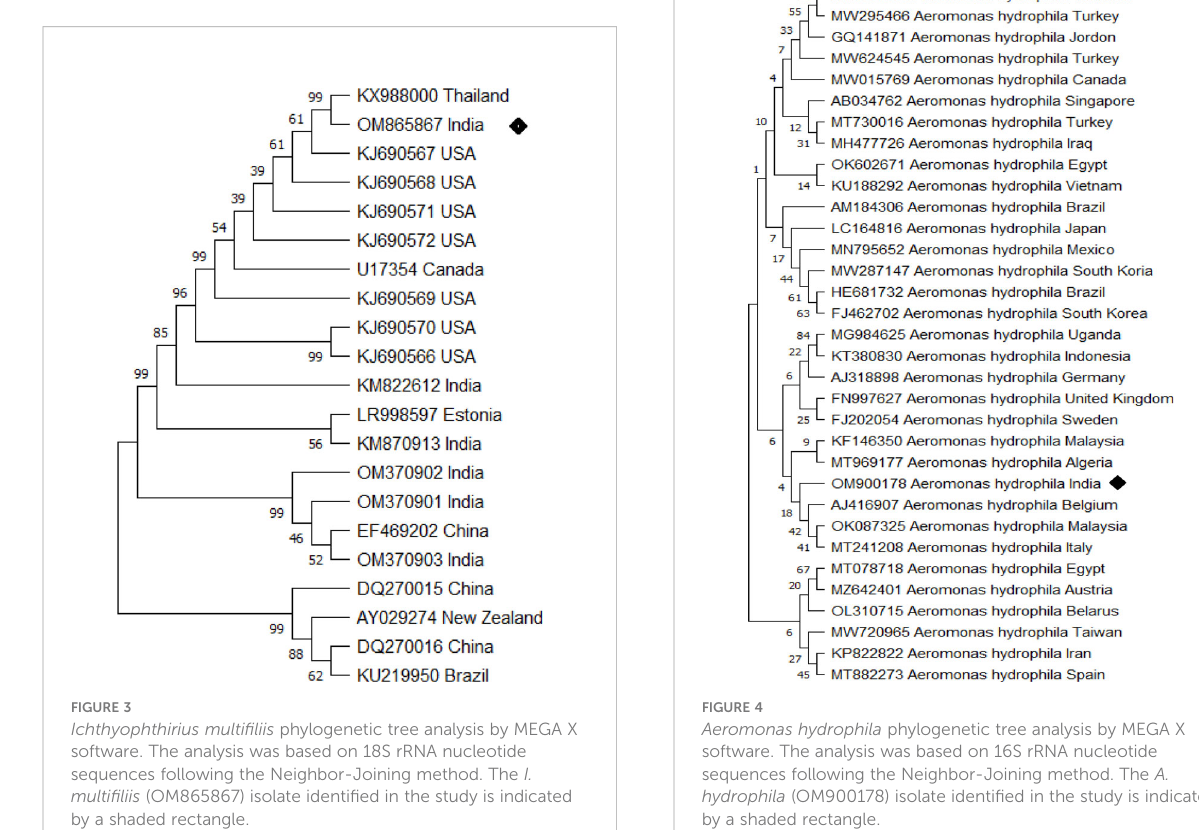
present signi fi cantly contributing to the antimicrobial ef fi cacy of the essential oil. The fi ngerlings exposed to turmeric oil in the range of 2.5 to 20 ppm (T1 – T4) did not exhibit any signi fi cant difference in survival when compared with unexposed, control fi ngerlings (Figure 6A). In contrast, 40 and 80 ppm (T5 and T6)